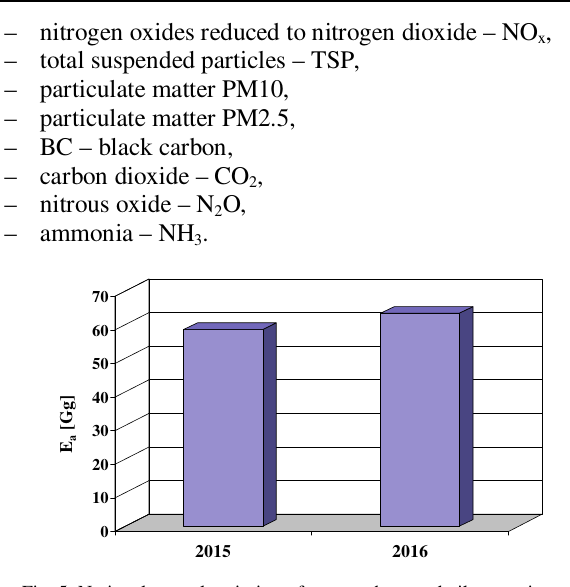
Fig. 5. National annual emission of non-methane volatile organic com- pounds from motor vehicles in 2015 and 2016